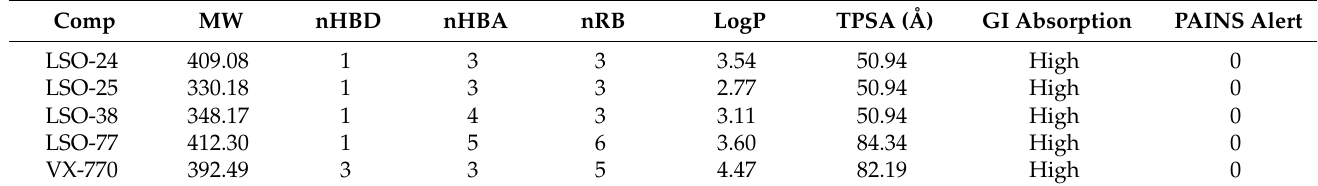
Table 2. In Silico Absorption, Distribution, Metabolism and Excretion (ADME) Analysis.